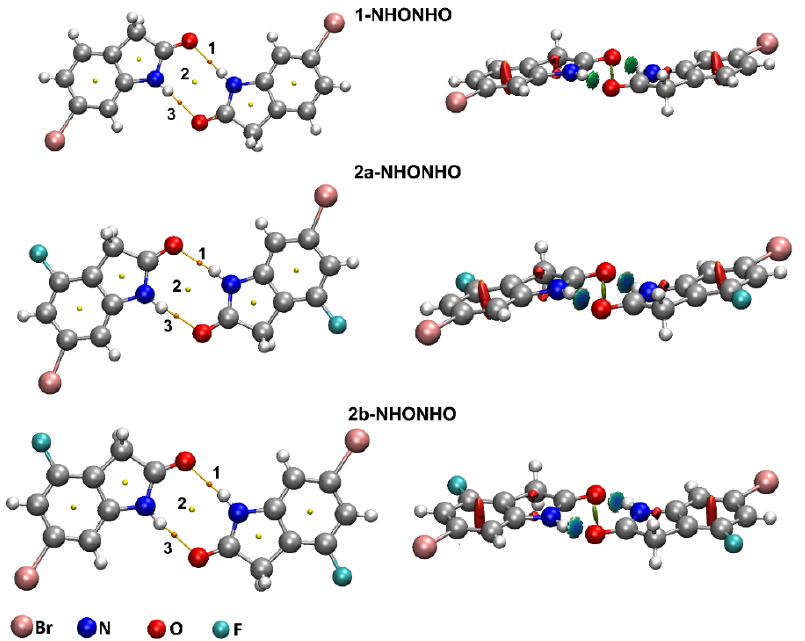
Figure 6. Critical points and RDG isosurfaces for 1-NHONHO, 2a-NHONHO and 2b-NHONHO dimers obtained with MP2/def2-TZVP theory level. The orange points indicate bond critical points (BCP), yellow points indicate ring critical points (RCP) and yellow lines indicate the bond paths. The RDG isosurfaces were obtained with isovalues of 0.65 a.u. The green blue-colored region indicates a hydrogen bonding NH···O interaction.